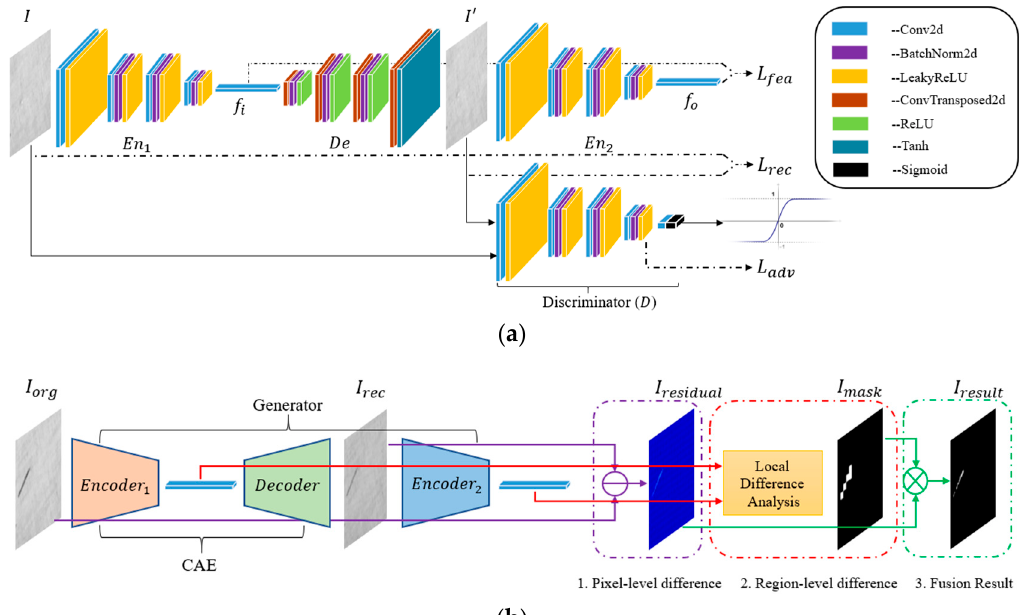
Figure 2. Overall architecture of the proposed model in the training and testing phases. ( a ) In the training phase, parameters of the whole network are learned by adversarial learning; ( b ) In the testing phase, pixel-level and regional-level differences between I org and I rec are evaluated after image reconstruction to obtain the final segmentaion